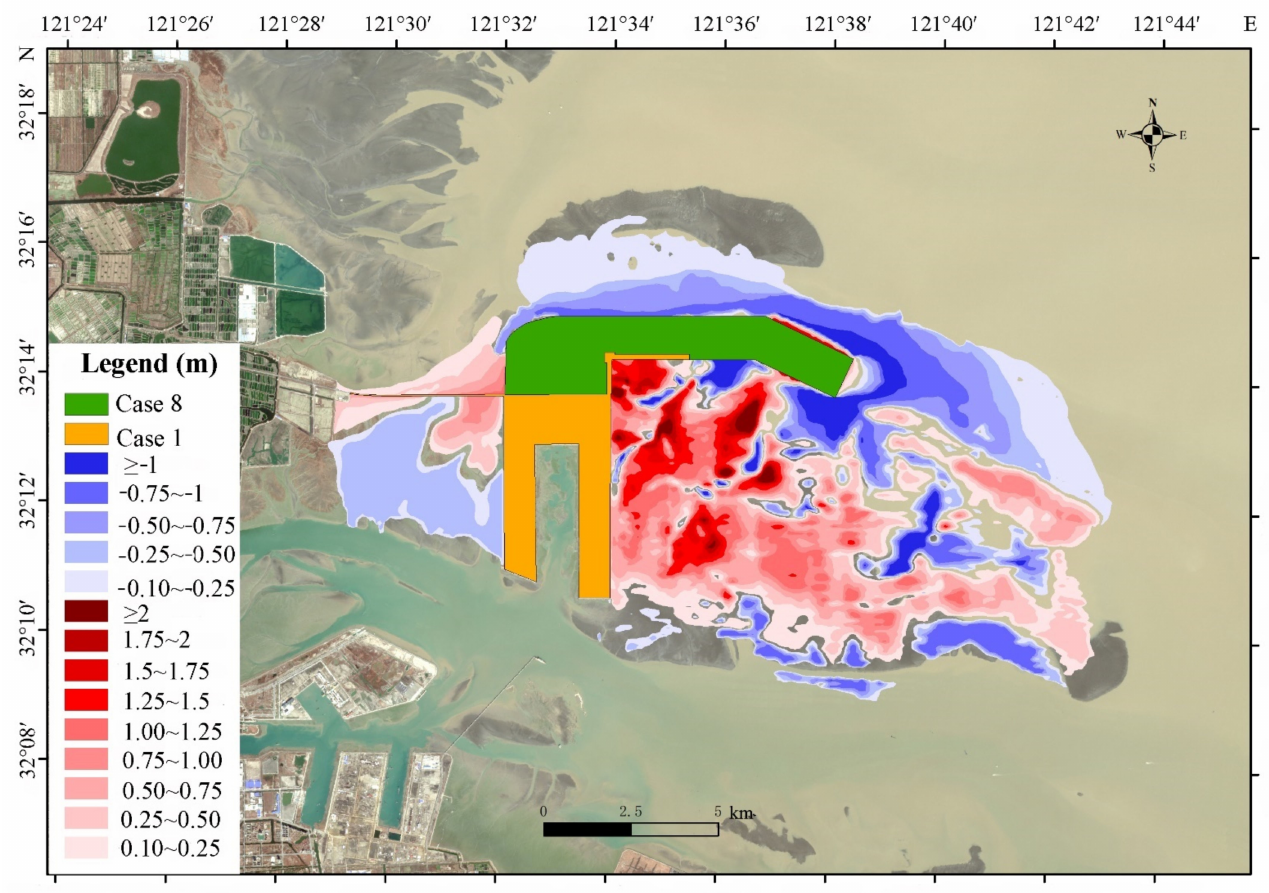
Figure 7. Topographic changes of model results in